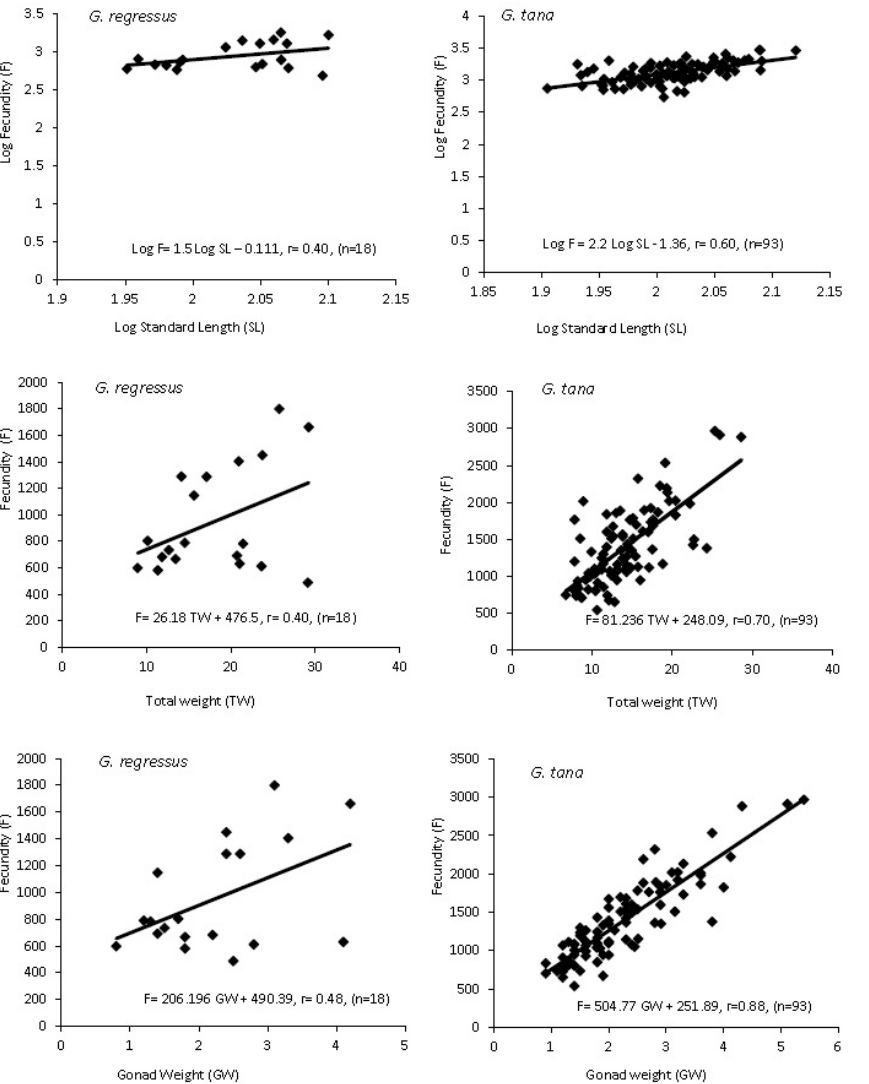
Figure 6. Absolute fecundity (F) as a function of Standard length (SL), Total Weight (TW), and Gonad Weight (GW) for Garra regressus and G. tana from Lake